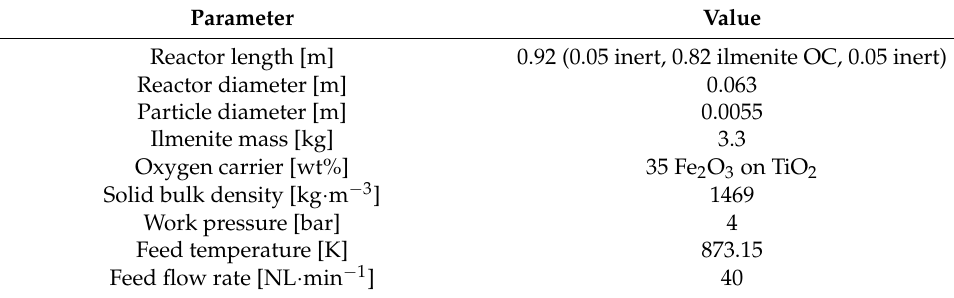
Table 2. Parameters used in the fuel reactor model